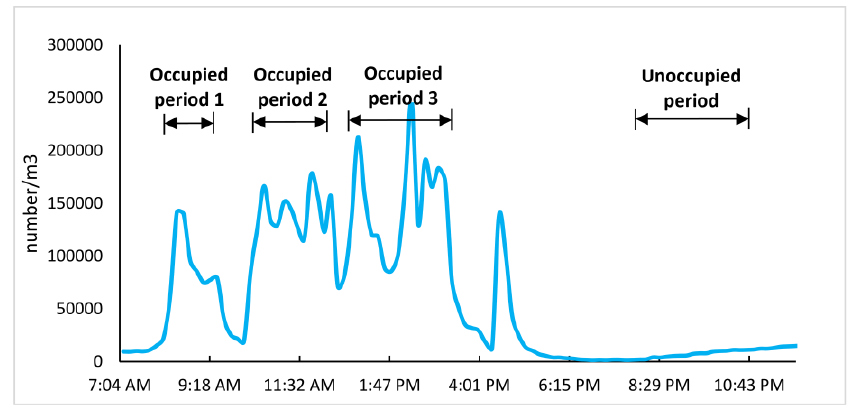
Figure 2. The figure shows a selection of occupied periods fluorescent bioaerosol counts (FBCs) at fine size A (0.5–3 μm) in the non-ultraviolet germicidal irradiation (UVGI) classroom from a typical sampling day.